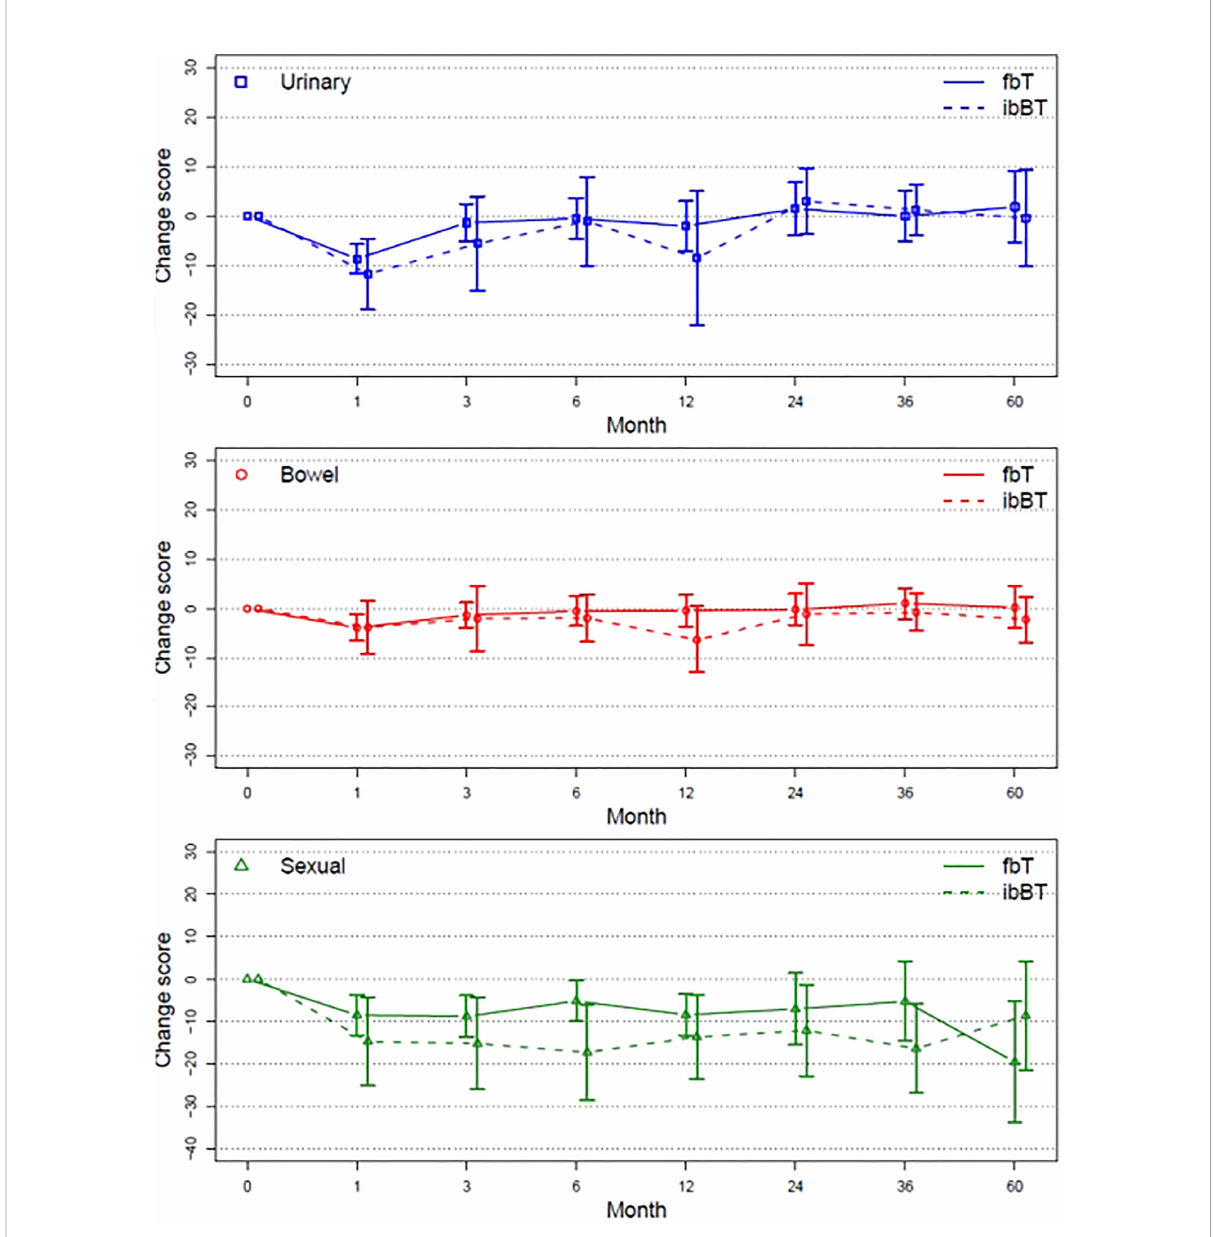
FIGURE 4 Mean change score from baseline (95% CI) plotted over time for urinary, bowel and sexual